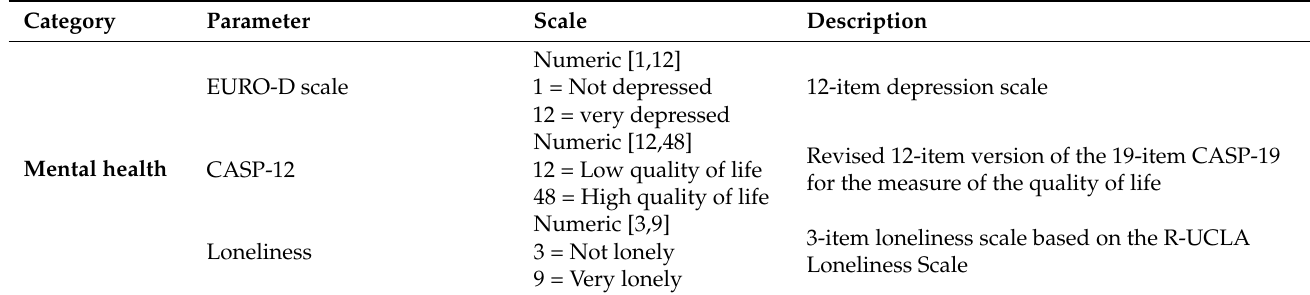
Table 2. Description of the physical and mental health and cognitive functioning parameters used in this